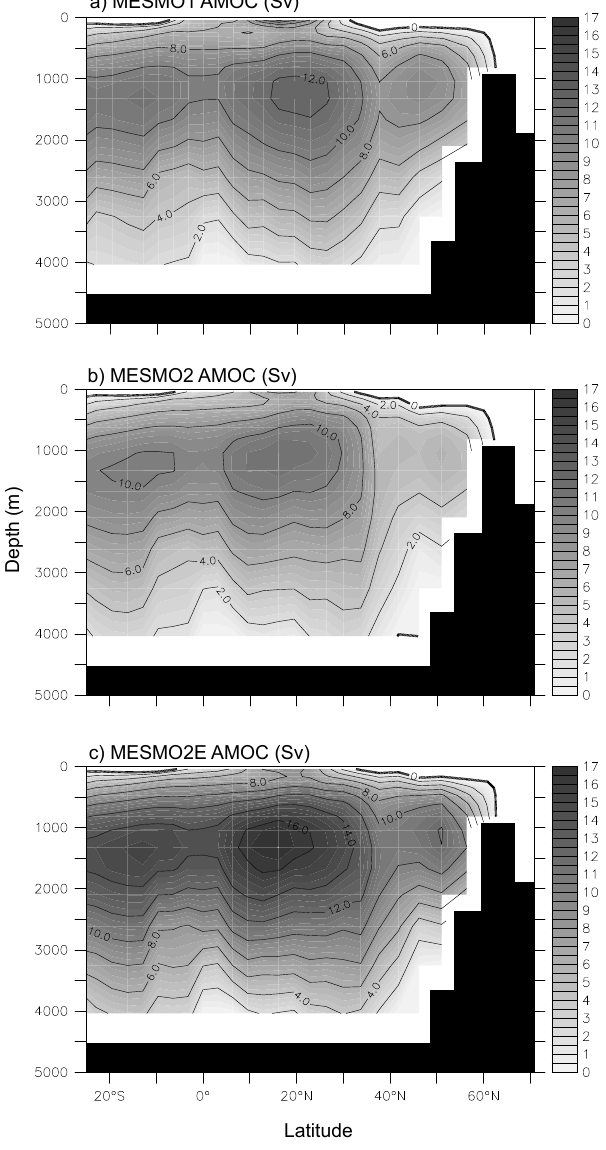
Fig. 2. The Atlantic meridional overturning circulation in three ver- sions of